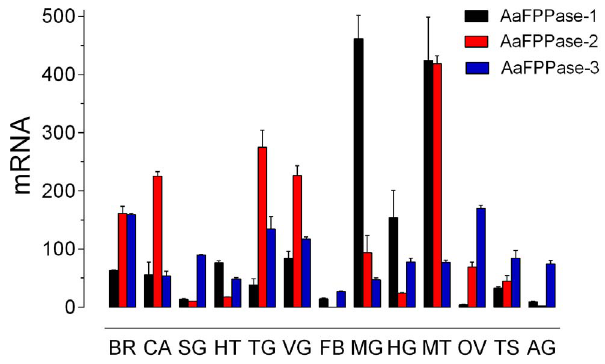
Figure 5. Tissue specific expression of Aa FPPases. All tissues were dissected from 3-day-old sugar-fed females, except for testis and accessory glands dissected from 3-day-old sugar-fed males. BR: brain; CA: corpora allata; SG: salivary gland; HT: heart; TG: thoracic ganglia; VG: ventral ganglia; FB: fat body; MG: midgut; HG: hindgut; MT: Malpighian tubules; OV: ovaries; TS: testis and AG: accessory gland. Each value represents the means 6 S.E.M of two independent biological replicates of 10–20 tissue samples evaluated in triplicate. Aa FPPase mRNAs are expressed as copy number of mRNA/10,000 copies of rpL32 mRNA.